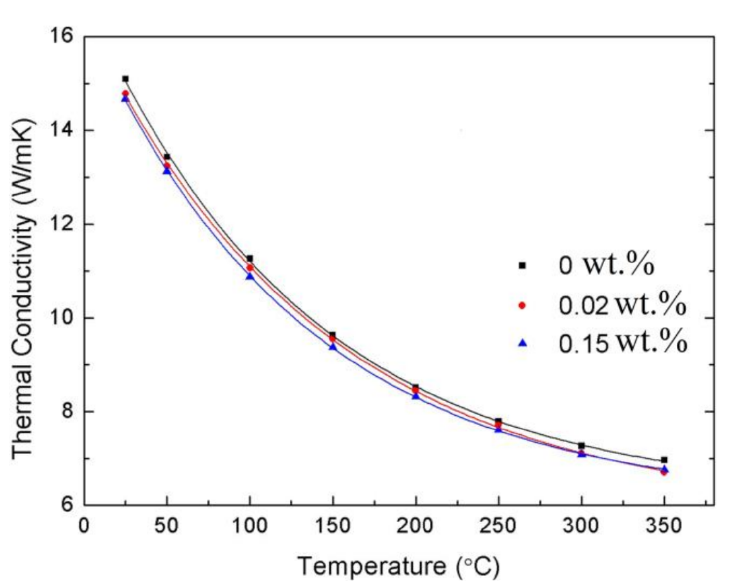
Figure 6. Thermal conductivity of the Y 2 O 3 ceramics with different contents of CaO versus tempera-